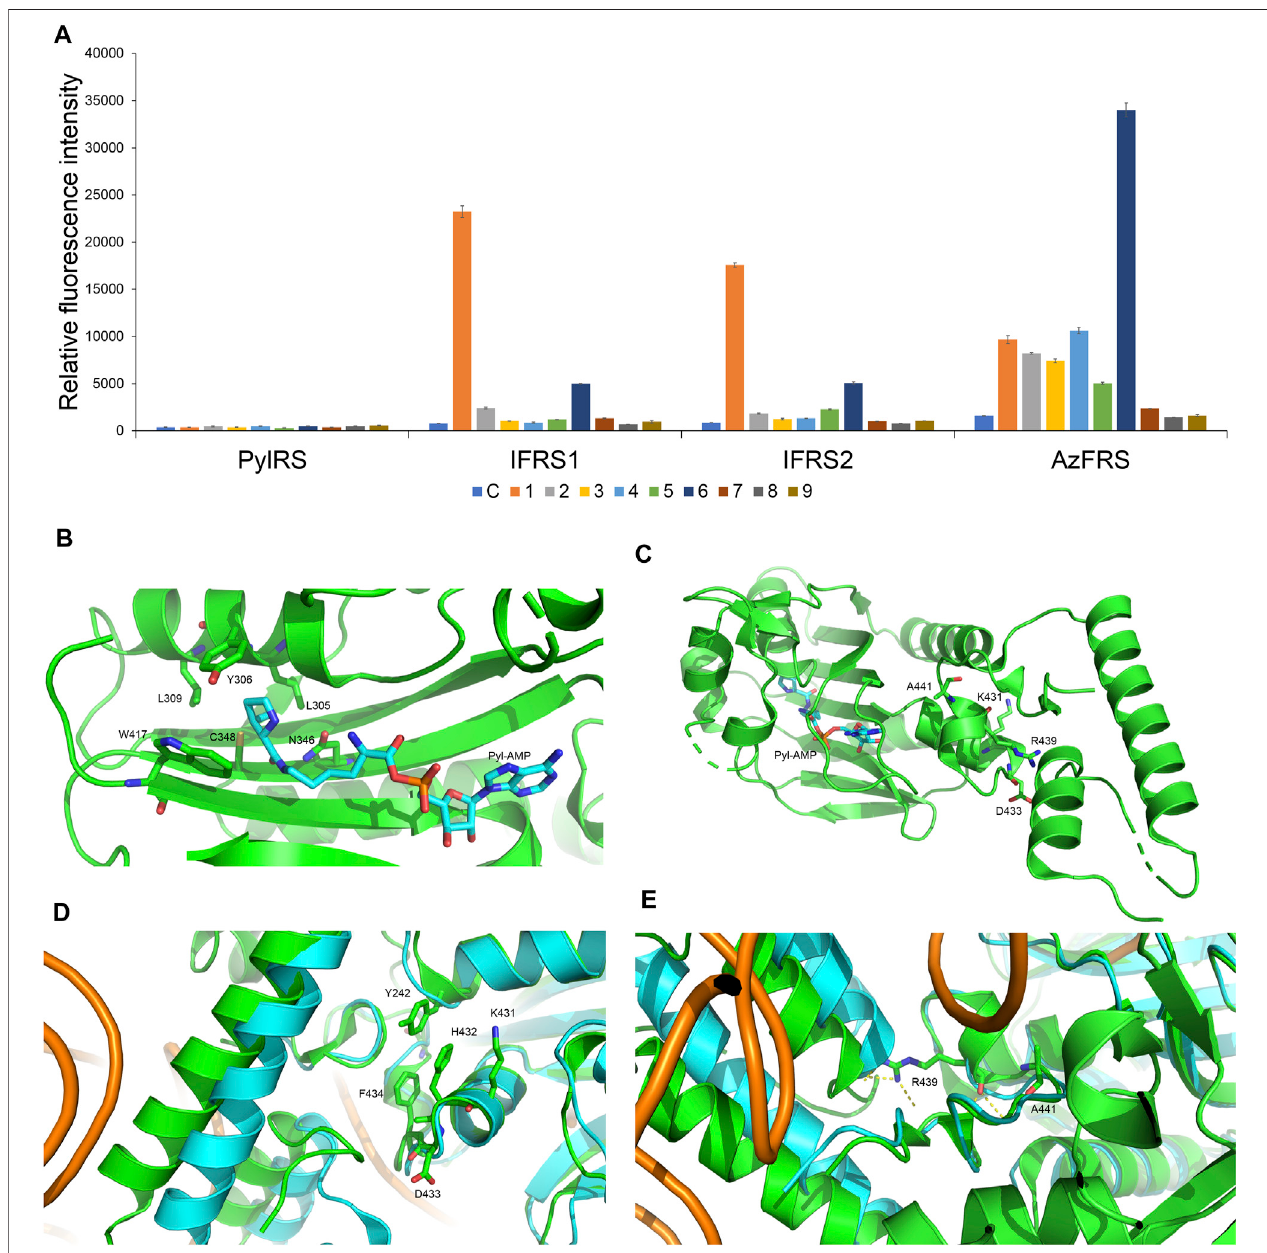
FIGURE 2 | Substrate speci fi city screening and C-terminal designs of evolved Mm PylRS. (A) The incorporation ef fi ciencies of PylRS variants, IFRS1, IFRS2, and AzFRS( Table1 ),aredeterminedby fl uorescenceemissionintensitiesobtainedfrom sfGFP-27am geneproducts.Proteinsareexpressedafterbeingsupplementedwith 1 mMncAAandIPTGinGMMLmediumat37 ° Cfor12 h.Cellsareexcitedat485 nm,andthe fl uorescenceemissionintensitiesaredetectedat535 nm.Thecelldensity is monitored bythe UVabsorbance at 595 nm. Cdenotes the control experiment thatcells were supplemented with1 mM IPTG only; 1 – 9 denote the experiments supplementedwith1 mMIPTGandncAAs 1 – 9 ( Scheme1 ).ThebackgroundsignalobtainedfromcellswithoutaddingIPTGissubtractedfromthesignalobtainedfrom each group. Error bars represent the standard deviation of sfGFP production from three repeated experiments. (B) The active site of Mm PylRS. (C) The structure of Mm PylRS CTD in the presence of Pyl-AMP substrate obtained from the X-ray co-crystal structure (PDB code: 2Q7H). The AMP-Pyl and six mutated sites from directed evolutionareshowninstickmode. Thedesigned mutationsites, K431, D433,and A441,inthisstudyarelabeled.TheresidueR439isalsolabeled toindicatethespatial arrangement toward the fi rst helix (position 191 – 201). (D) and (E) The structure of Mm PylRS CTD (green) and its superimposition with the Dh PylRS CTD (cyan)/tRNA Pyl (orange) complex. The structures are illustrated based on two PDB entries 2Q7H and 2ZNI. The amino acids proposed to interact with the mutated site are labeled. The yellow dotted line indicates the hydrogen